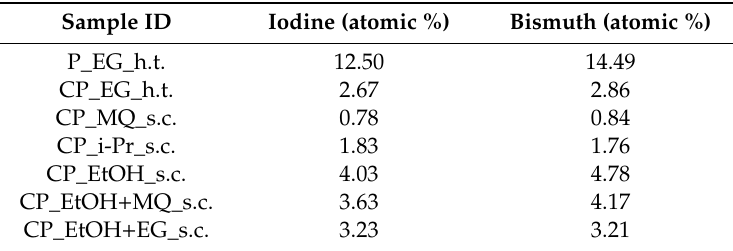
Table 2. The atomic ratio of the Bi and I on the BiOI coated ceramic papers, measured by SEM–EDX. The ratios of the iodine to bismuth were approximately one to one.